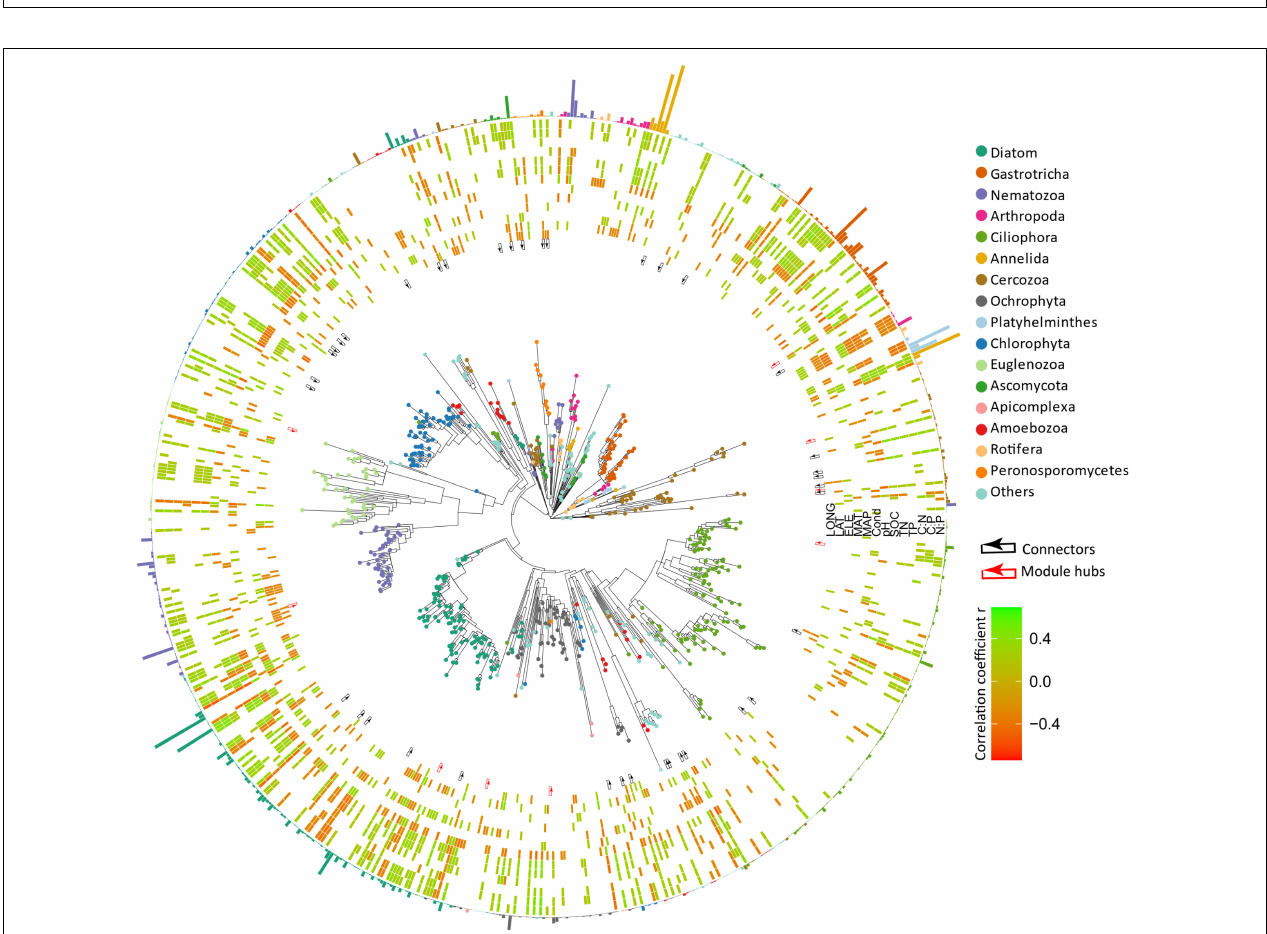
FIGURE 6 | Phylogenetic tree of microbial eukaryotes was constructed by OTUs with relative abundance > 0.01%. Tree tips are colored by major phylum. The red and black arrows in the inner ring represent module hubs and connectors of the co-occurrence network. The heatmap indicates the relationships between OTUs and environmental variables (the color represents Spearman’s correlation coefficient and only significant results are shown). The bars in the outer ring represent the relative abundance of the OTUs and are colored by phylum.